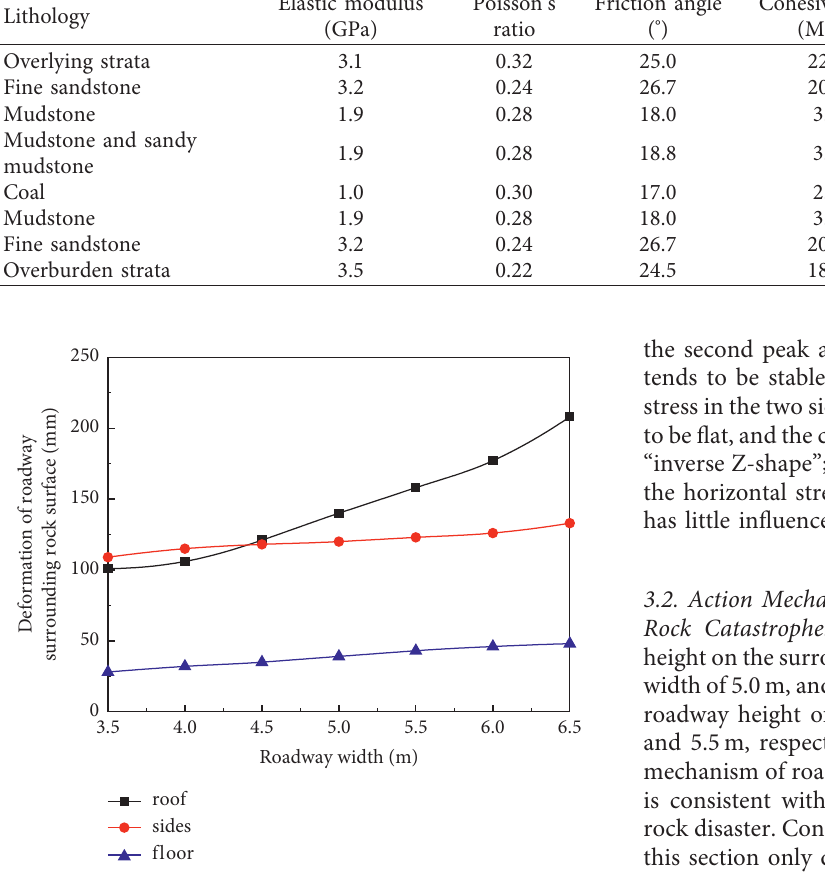
Figure 5: Influence of roadway width on surface deformation of surrounding